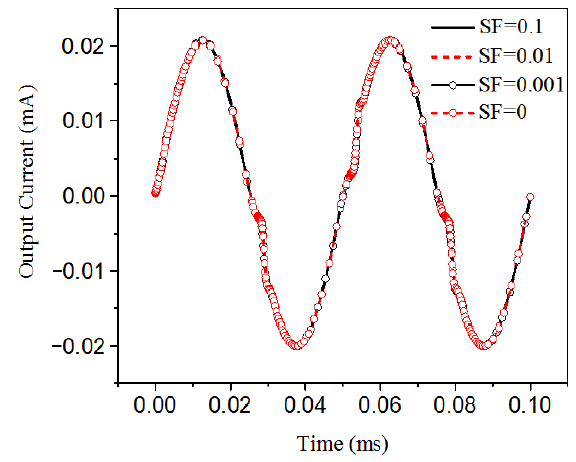
Figure 11. Simulation results with different SF.